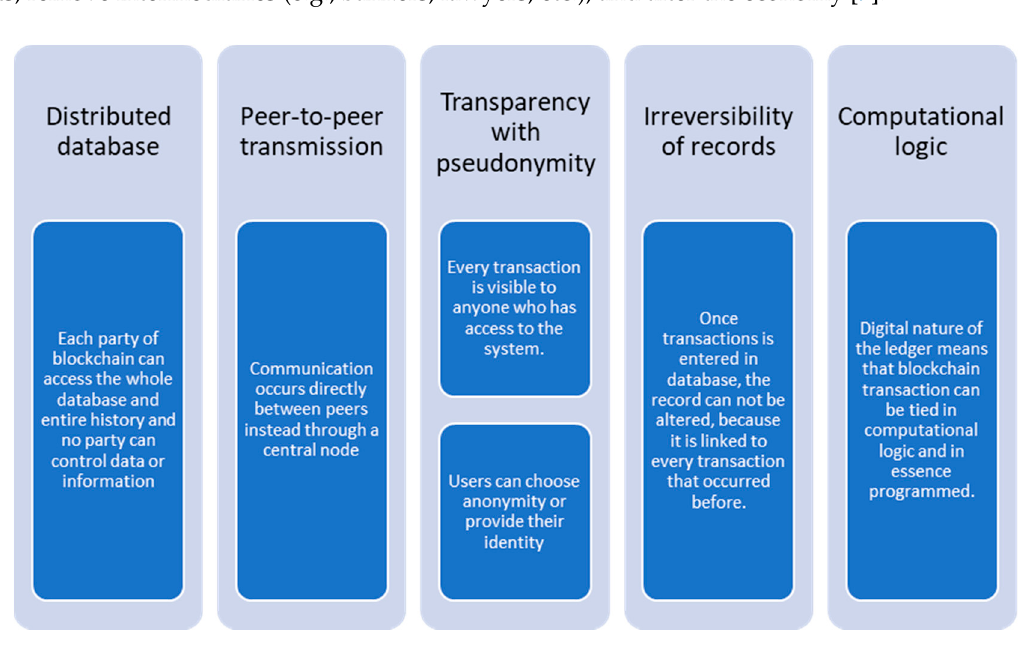
Figure 1. How blockchain works [9].